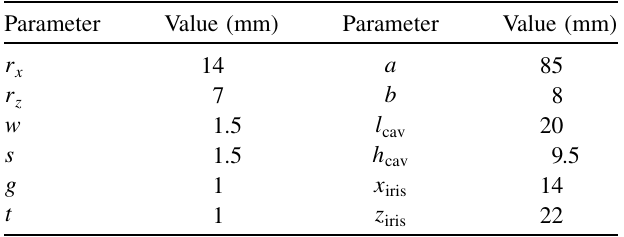
TABLE I. Geometrical parameters for designed structure (see Figs. 1 and 2) with operating frequency of 2.037 GHz.